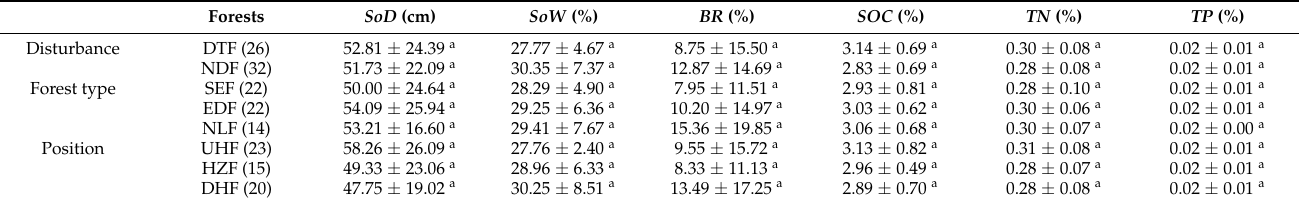
Table 5. Statistics of soil variables in bamboo–woodland interfaces in various disturbances, forest types and